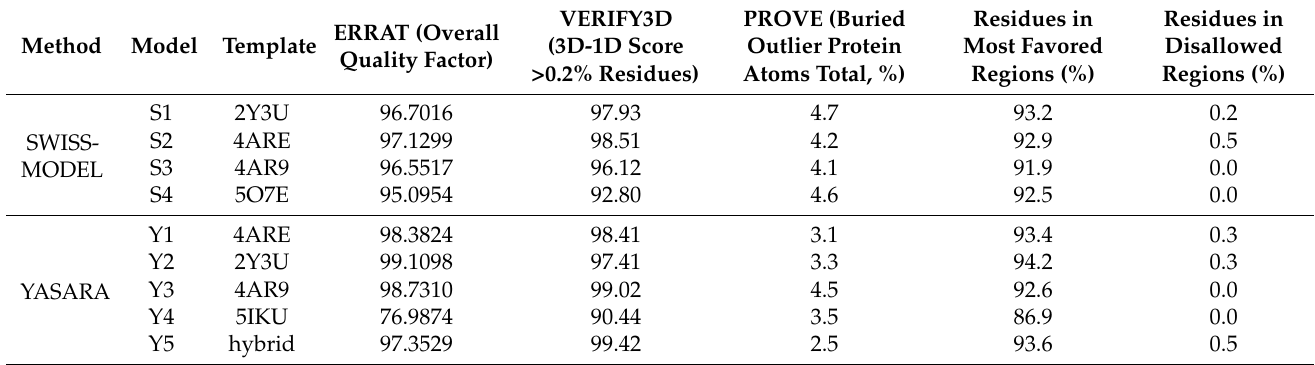
Table 4. Quality parameters of the generated models of C. perfringens